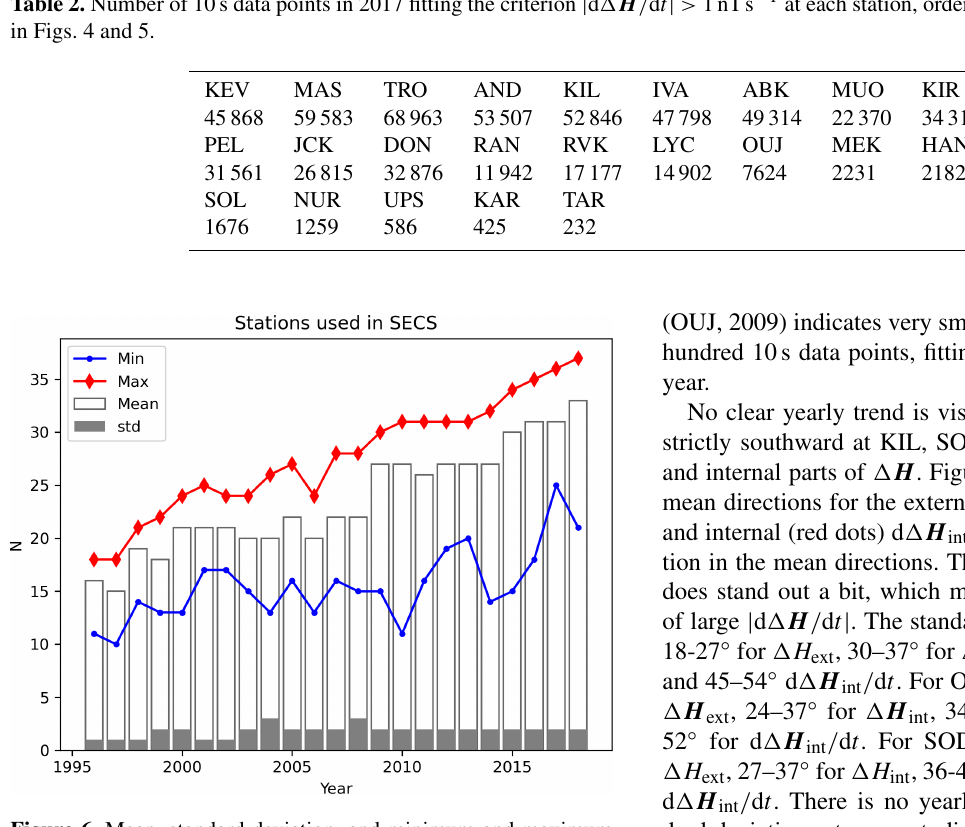
Figure 6. Mean, standard deviation, and minimum and maximum number of stations used in SECS analysis per year. Numbers are calculated from daily